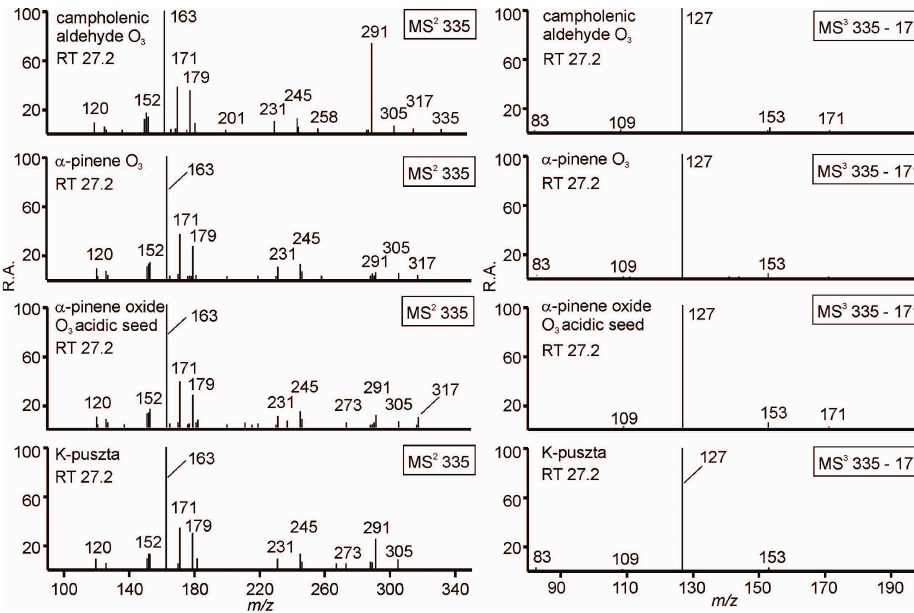
Fig. 6. MS 2 and MS 3 data for the m / z 335 compound from different SOA filter samples and an ambient